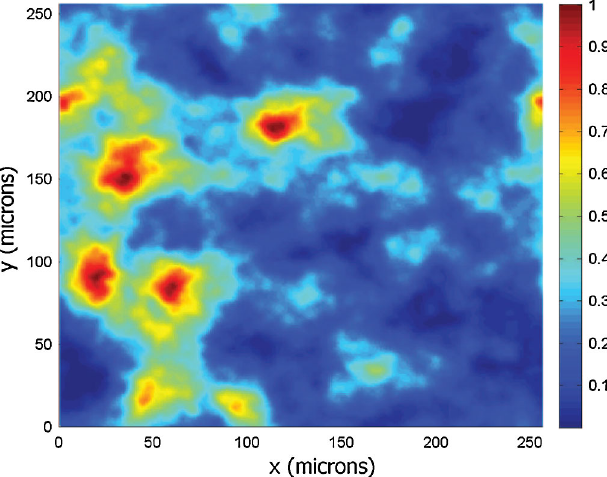
FIG. 5. x - z trace space after a drift and longitudinal dispersion without emittance (upper plot) and with 1 mm mrad emittance (lower plot) showing the effect of Landau damping on the transverse structure of